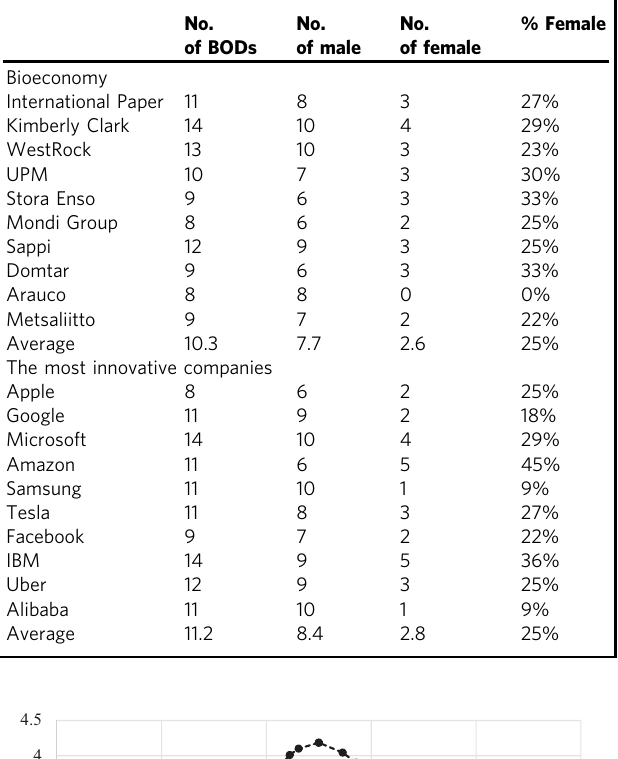
Table 5 Age diversity in the bioeconomy and the most innovative company groups.